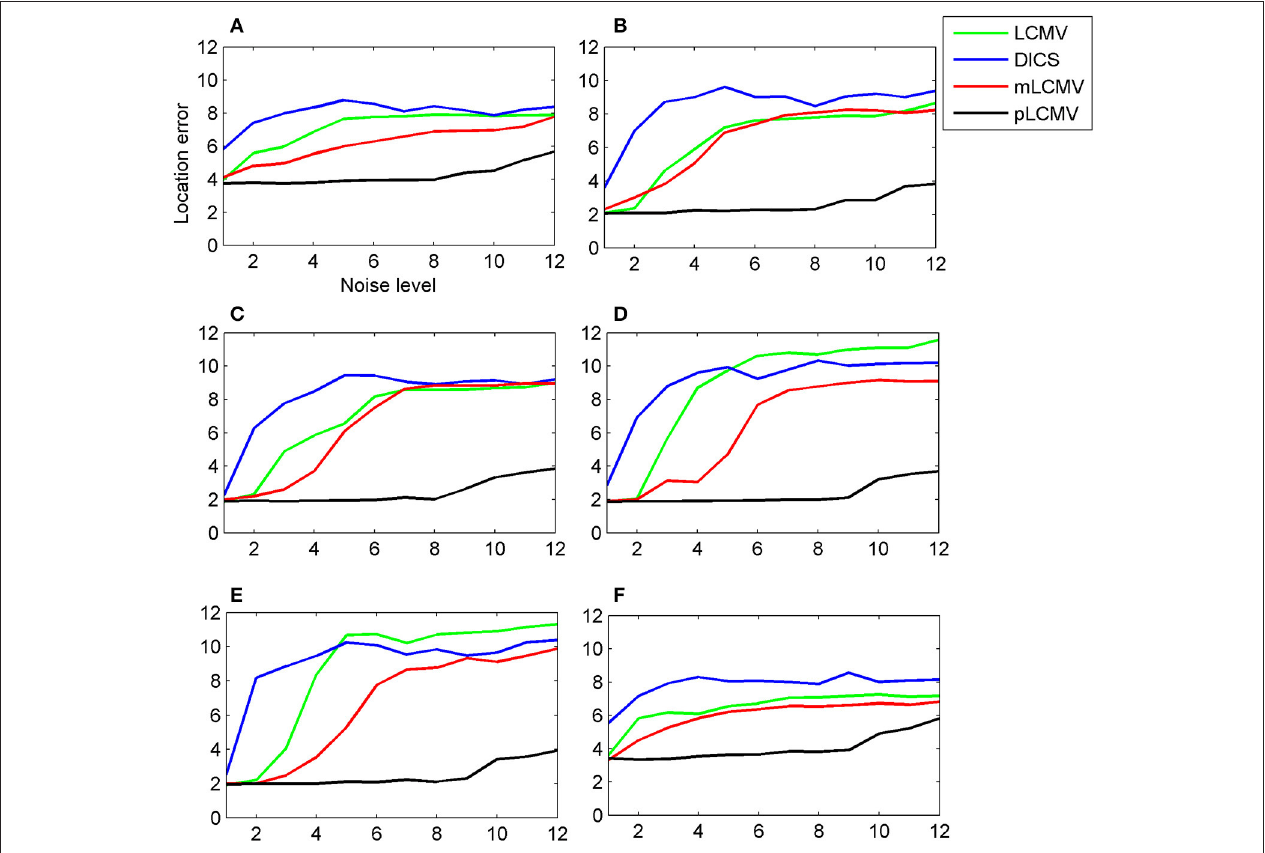
FIGURE 4 | For a simulated data generated by an aperiodic signal (sinc) plus the Gaussian noise, the spatial accuracy of the proposed approach (pLCMV) was compared with that of the other three approaches (DICS, LCMV, mLCMV). The x-axis of each plot represents the noise level, and the y-axis represents the location error. Each plot shows a comparison of the localization results of the four approaches based on simulated data generated for six different locations of the brain. The six locations were the left mesial temporal lobe (A) , right lateral temporal lobe (B) , right frontal lobe (C) , right occipital lobe (D) , right parietal lobe (E) , and right mesial temporal lobe (F) . Plots (A) and (F) represent deep sources; the rest represent shallow sources.